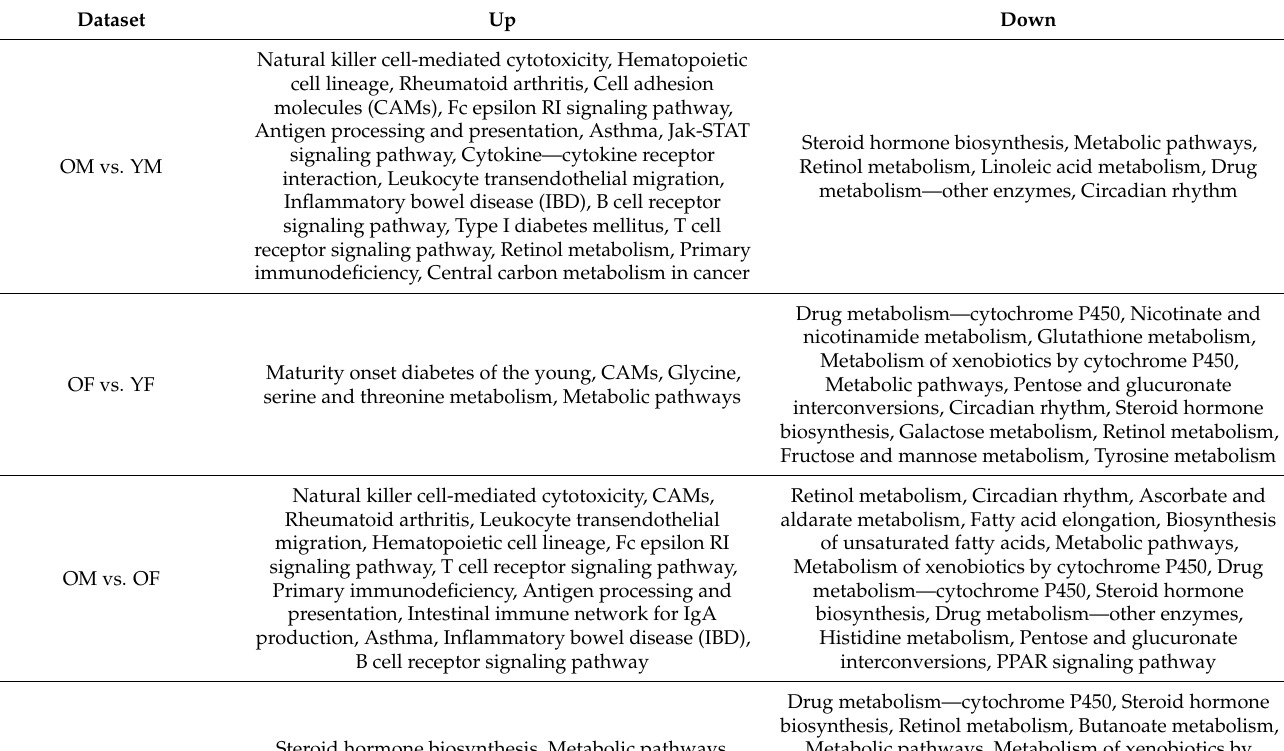
Table 1. KEGG pathways of the DEGs involved in immunity, inflammation, metabolism,